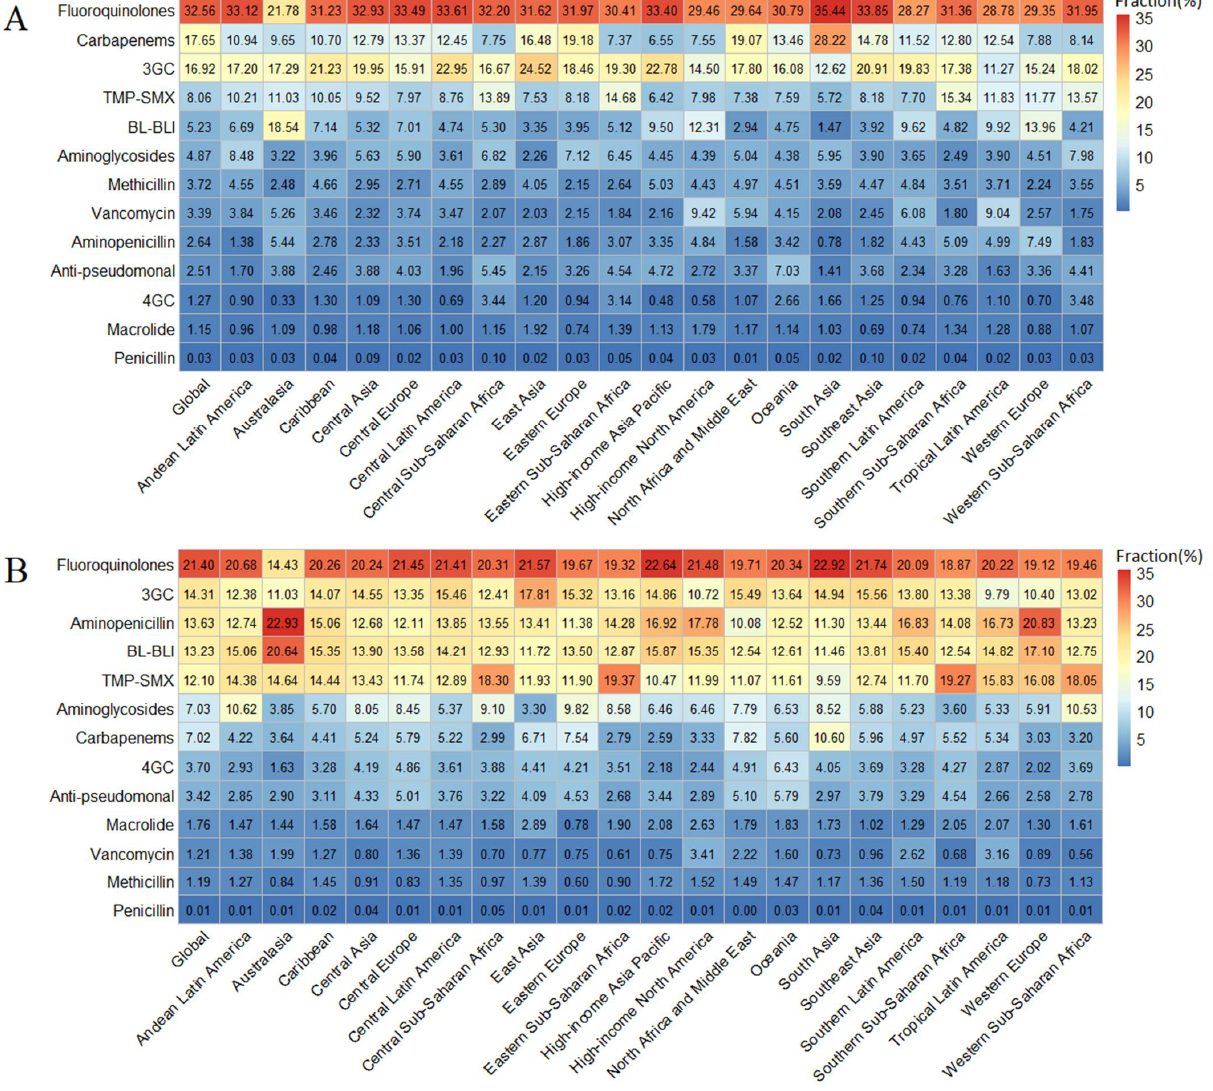
Figure 3. Fractions of deaths attributable to ( A ) and associated with ( B ) bacterial AMR among 21 GBD regions and 13 antibiotic classes, 2019. 3GC = third-generation cephalosporins. 4GC = fourth- generation cephalosporins. Anti-pseudomonal = anti-pseudomonal penicillin or beta-lactamase inhibitors. BL-BLI = β-lactam or β-lactamase inhibitors. Resistance to 1+ = resistance to one or more drugs. TMP-SMX = trimethoprim/sulfamethoxazole. AMR = antimicrobial resistance. GBD = Global Burden of Diseases, Injuries, and Risk Factors